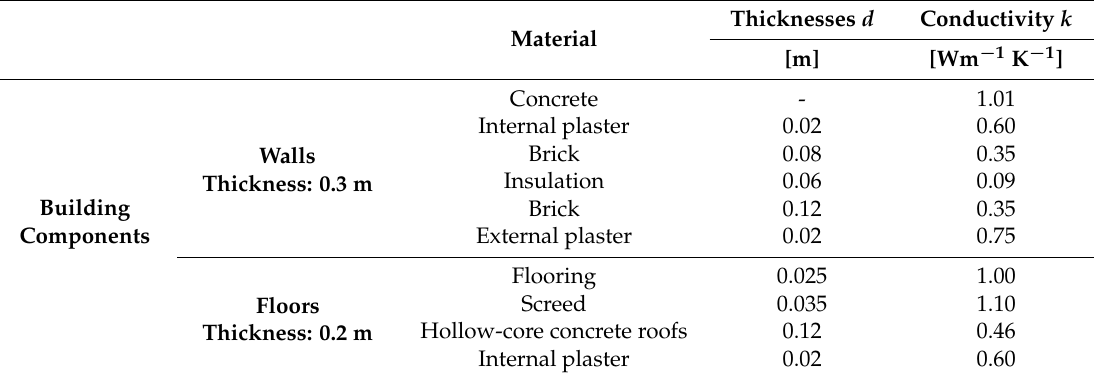
Table 1. Thickness and conductivity of the materials constituting the building